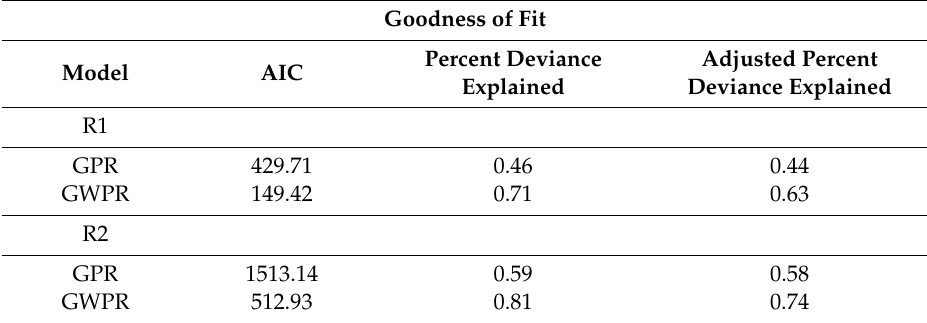
Table 4. Comparison of the global Poisson regression (GPR) and geographically weighted Poisson regression (GWPR)